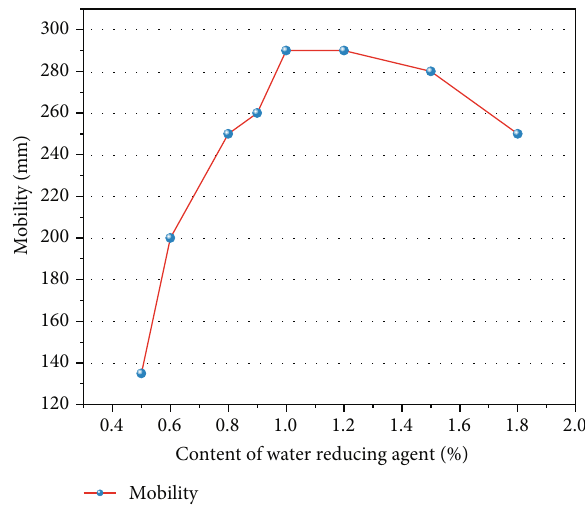
Figure 12: E ff ect of di ff erent dosages of superplasticizers on fl